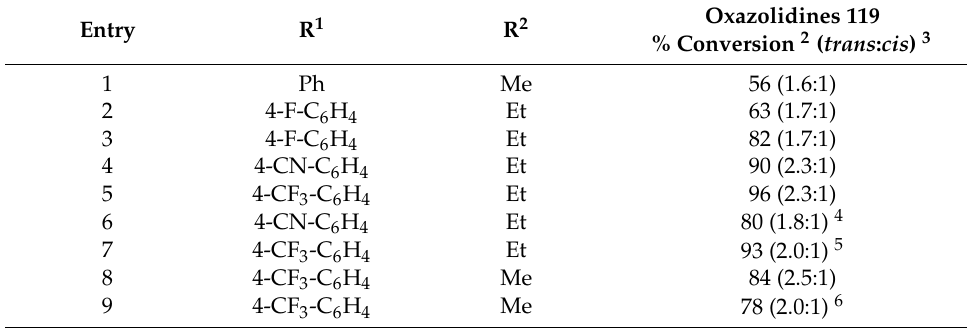
Table 15. Cycloaddition of N -metalated azomethine ylide 118 to benzaldehyde ( 2a ) (Scheme 29) 1 . Entry